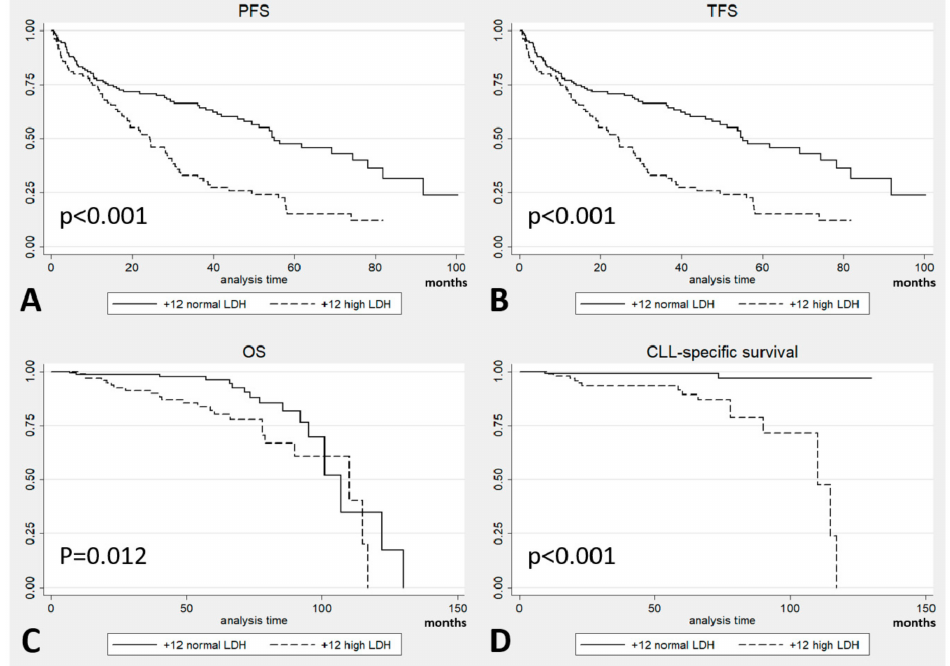
Figure 5. Outcomes in the validation cohort by Lactate DeHydrogenase (LDH) levels: ( A ) Progression- free-survival (PFS); ( B ) Treatment-free-survival (TFS); ( C ) Overall survival (OS); and ( D ) Chronic Lymphocytic Leukemia (CLL)-specific